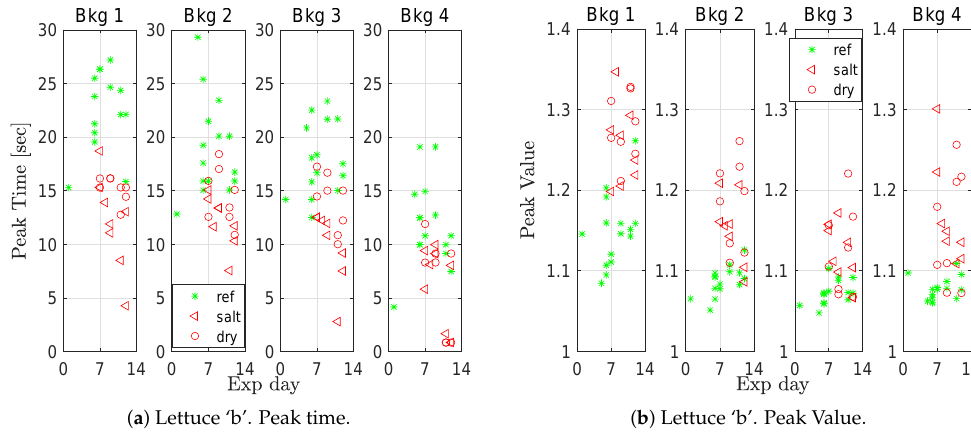
Figure 6. Peak time ( a ) and peak value ( b ) of the fluorescence step response for measurements on lettuce ‘b’; healthy (green star), as well as salt (red triangle) and dry (red circle) stressed. The first subplot (on a and b) corresponds to the lowest background light level (Bkg